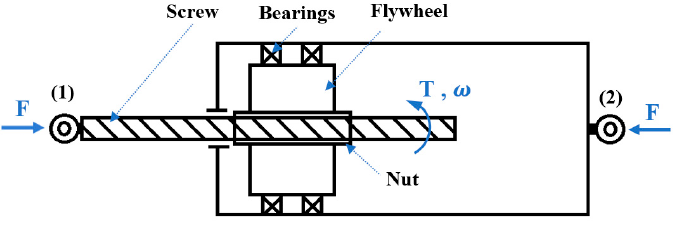
Figure 10. A schematic of a ball-screw type inerter.